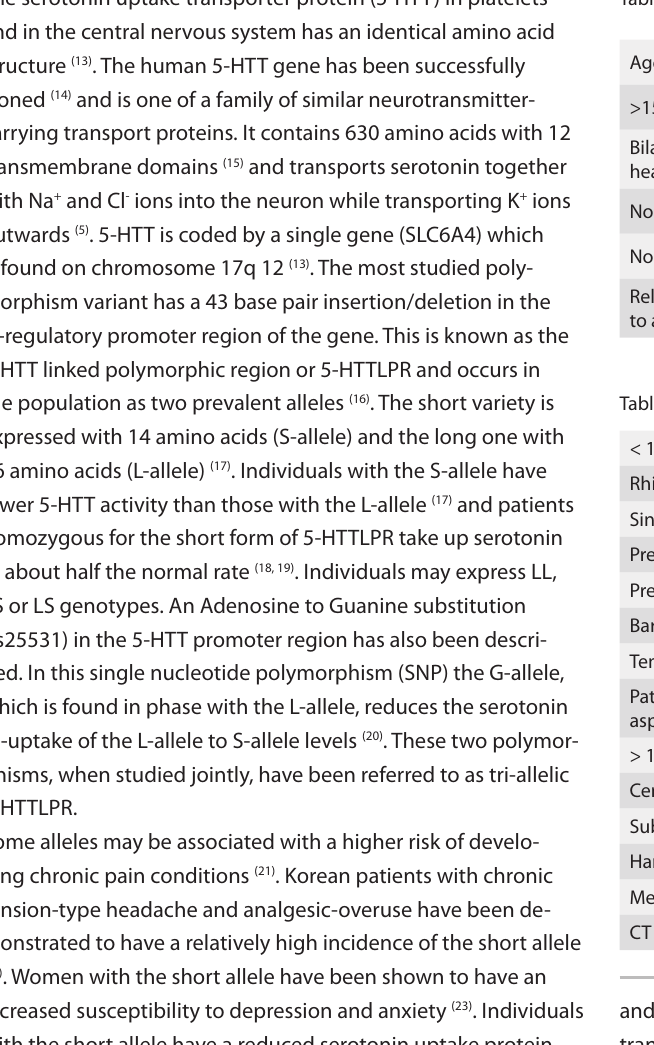
Table 1. Study inclusion criteria.